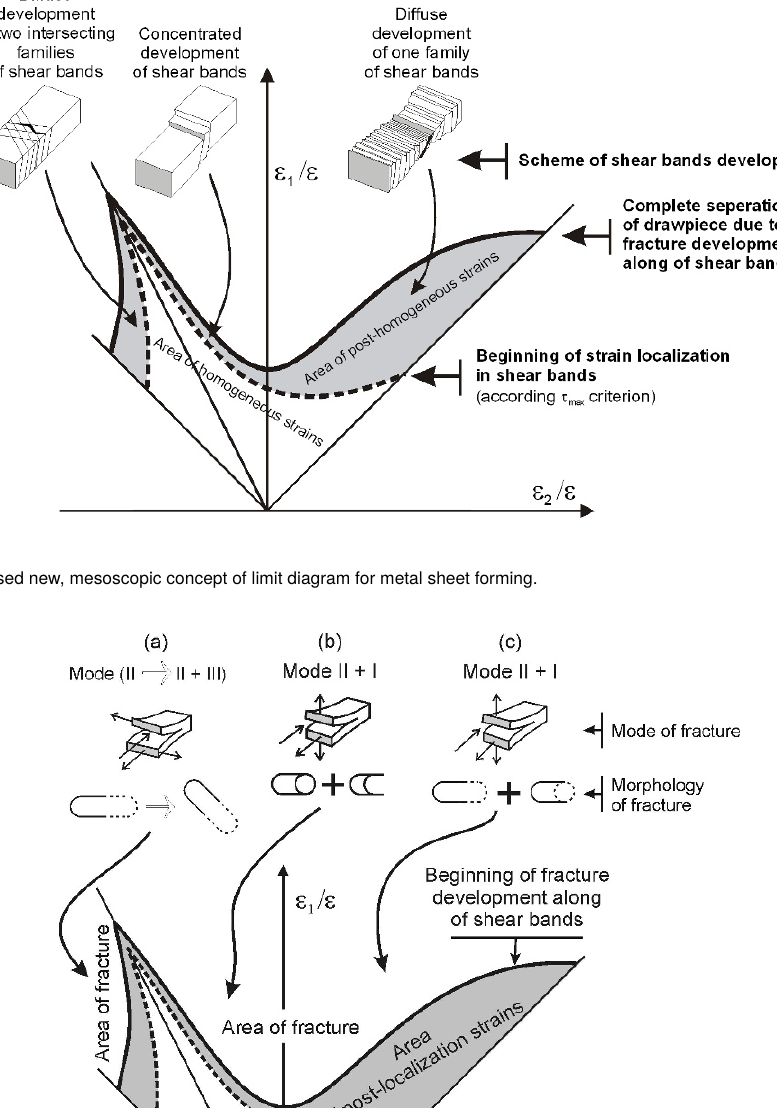
ates both the criteria for predicting the commencement of fracture, and the criteria for controlling the course of and/or the criteria for preventing shear fracture. Conse- quently, this model may be applied wherever large local